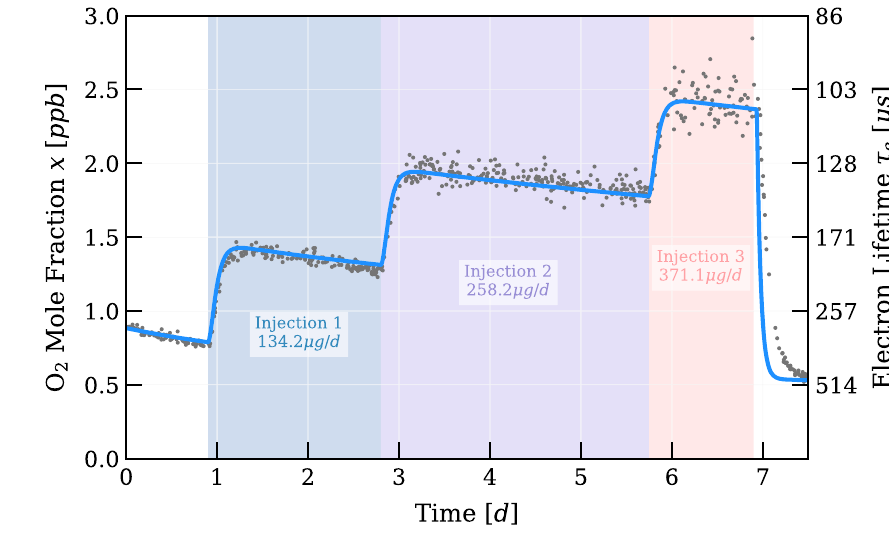
Fig. 6 Injection procedure performed with an empty tube substituted for the O 2 filter, in order to measure the rate of interphase transport in the LXe pump buffer. The colored regions indicate the three continuous injections. The decrease in PM O 2 mole fraction x during each period is mainly due to the reduction of the dominant O 2 source in the pump buffer volume Λ P throughout the period shown, though the depletion of O 2 in the finite injector reservoir volume also plays a significant role during the “Injection 3” period. The LXe flow in the circuit was 0.32L/min for the full